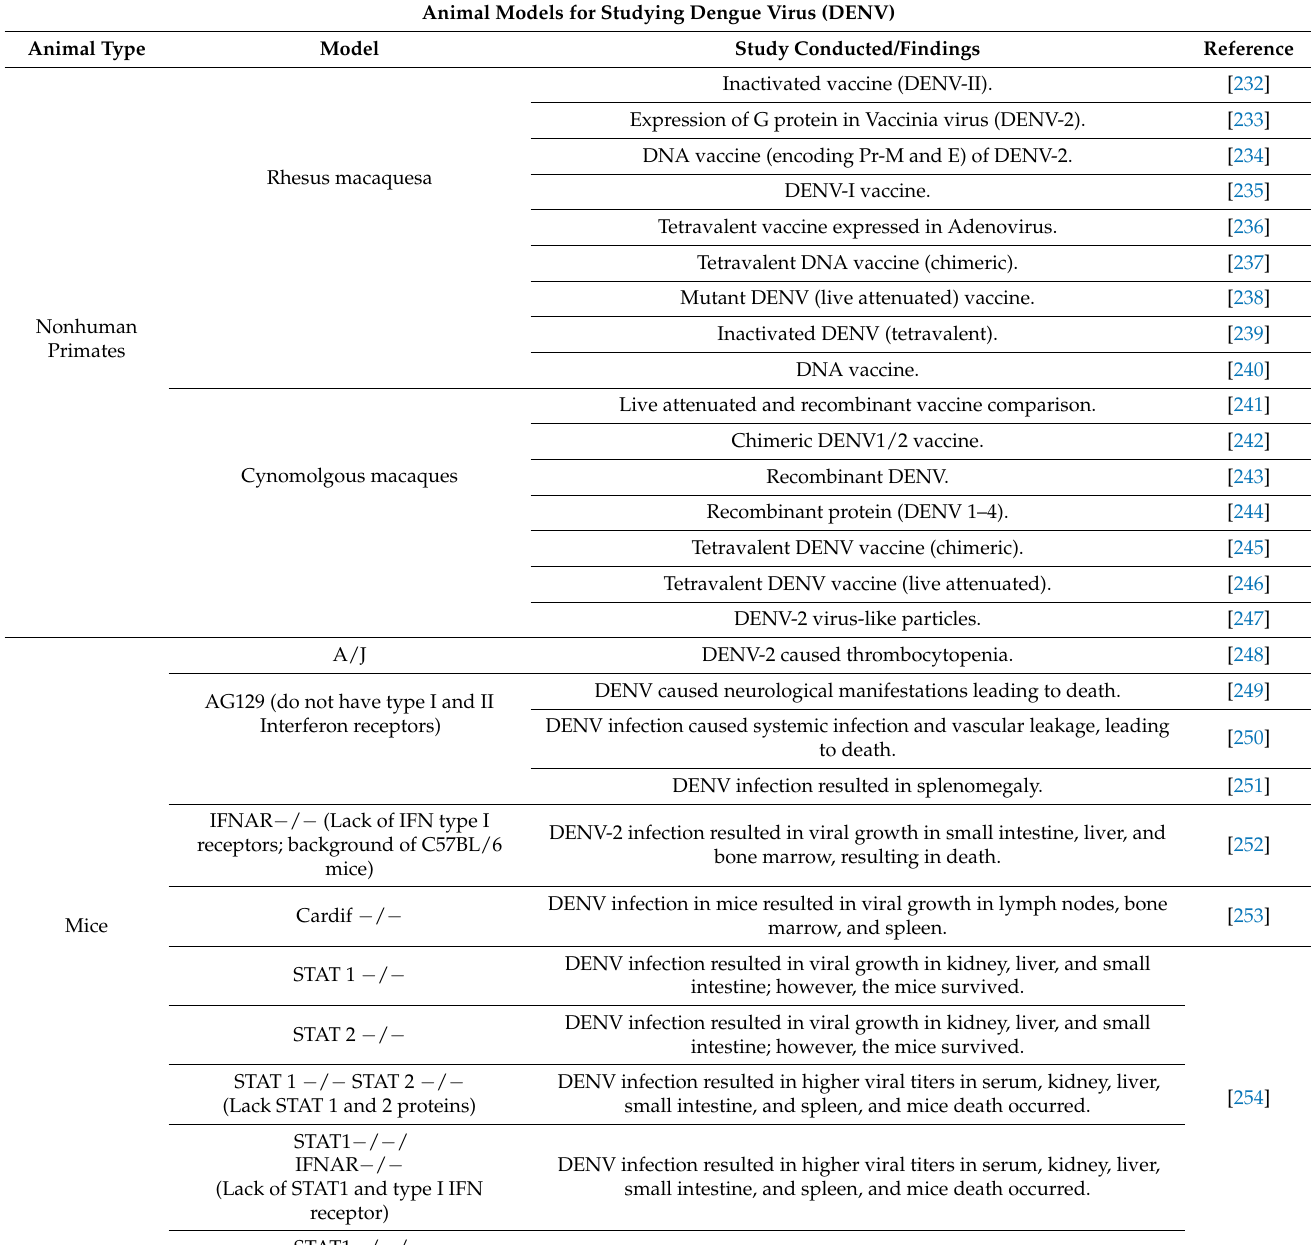
Table 4. Animals and cellular models for studying Flavivirus pathogenesis/vaccine development. Animal Models for Studying Dengue Virus